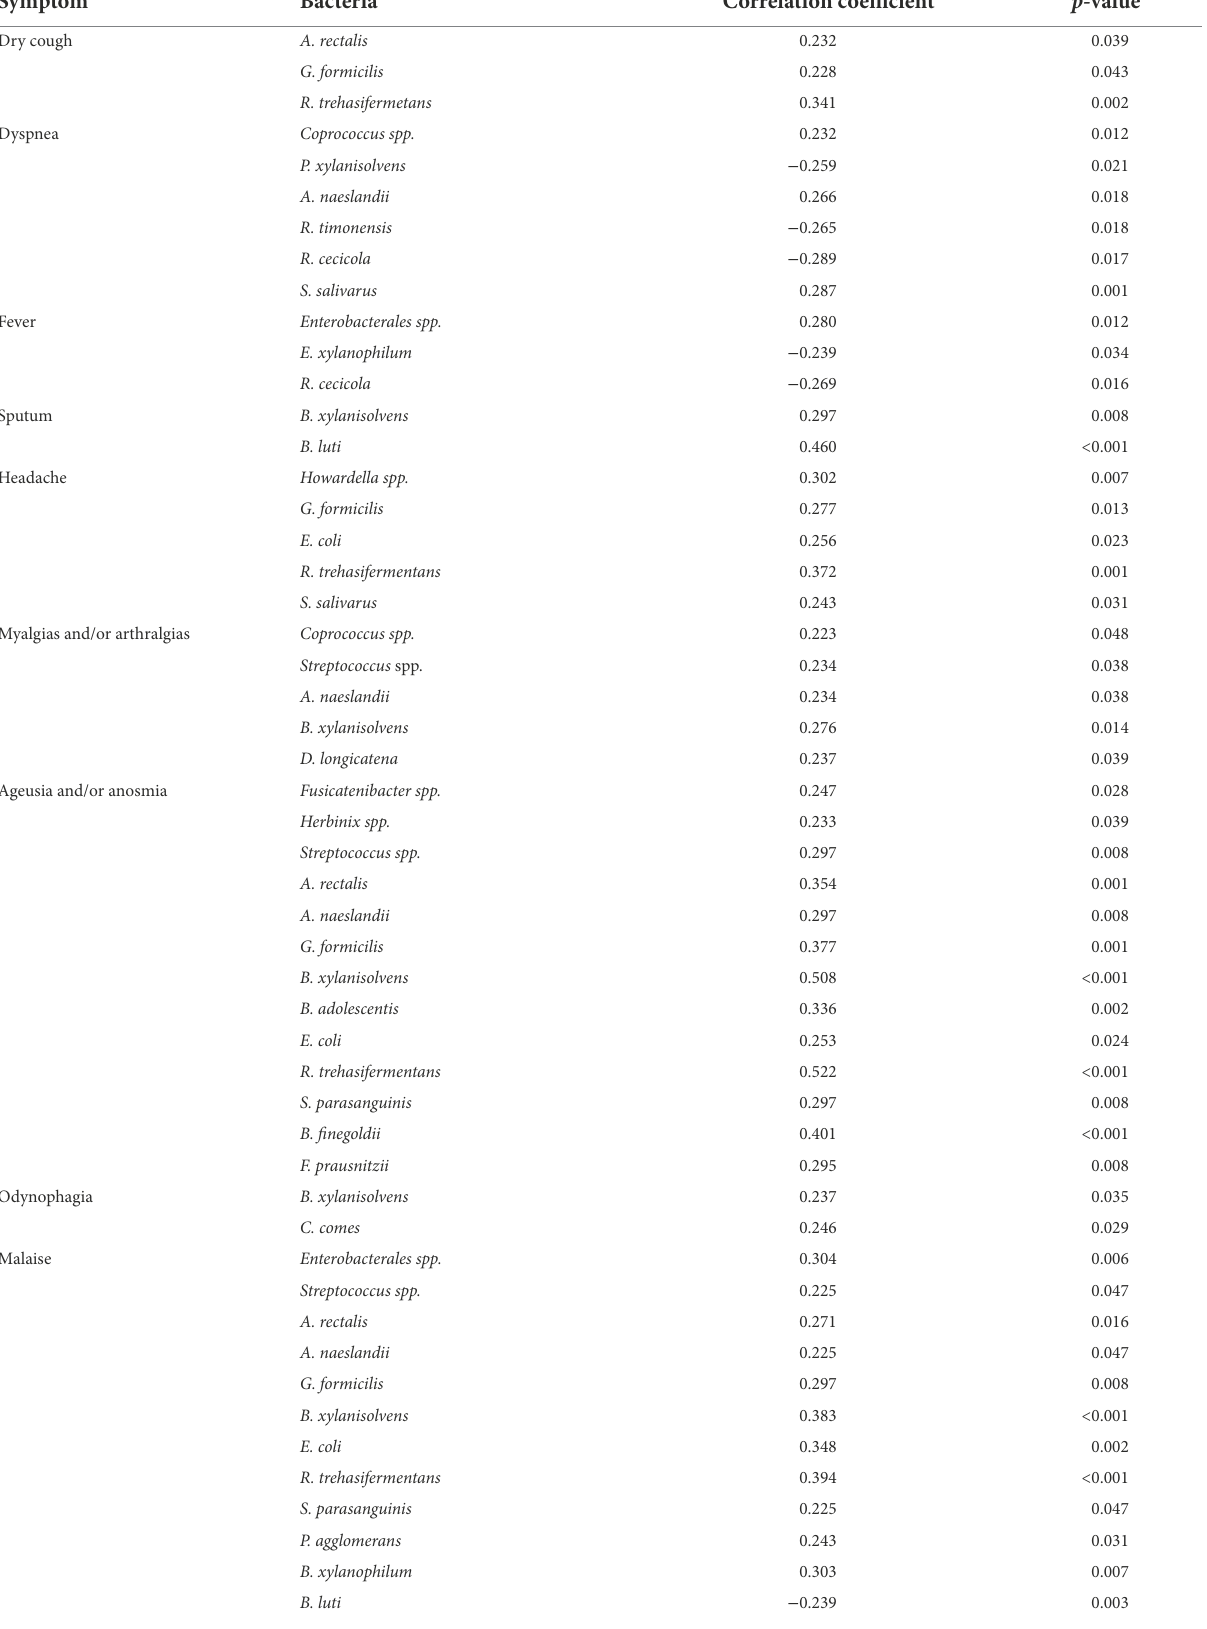
TABLE 2 Correlation coefficients of microbiota signatures for the most common COVID-19 symptoms. Symptom Bacteria Correlation